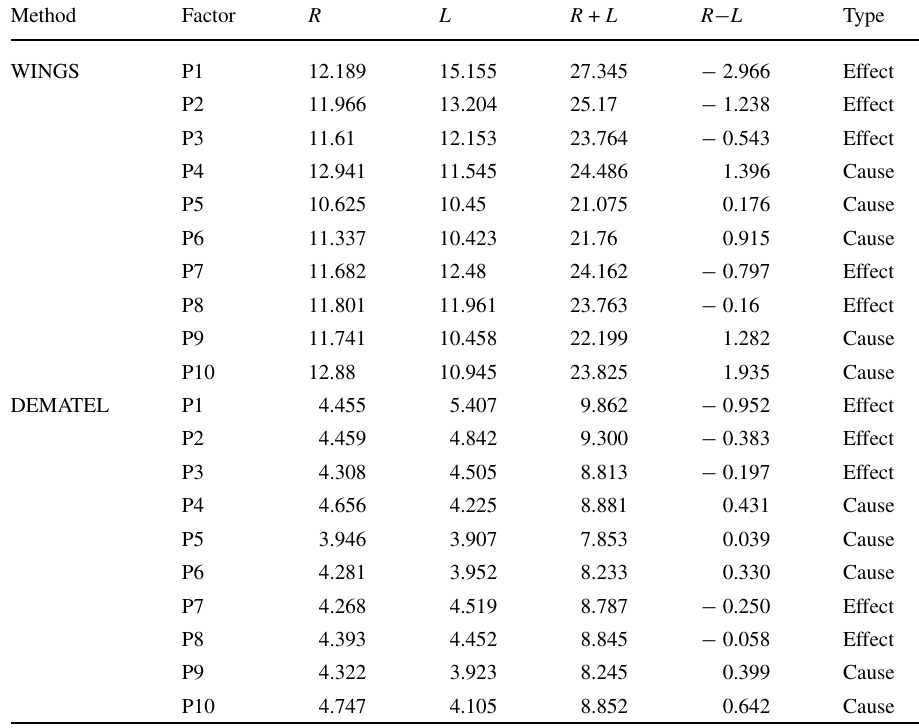
Table 7 The R&L values and types of factors with WINGS and DEMATEL